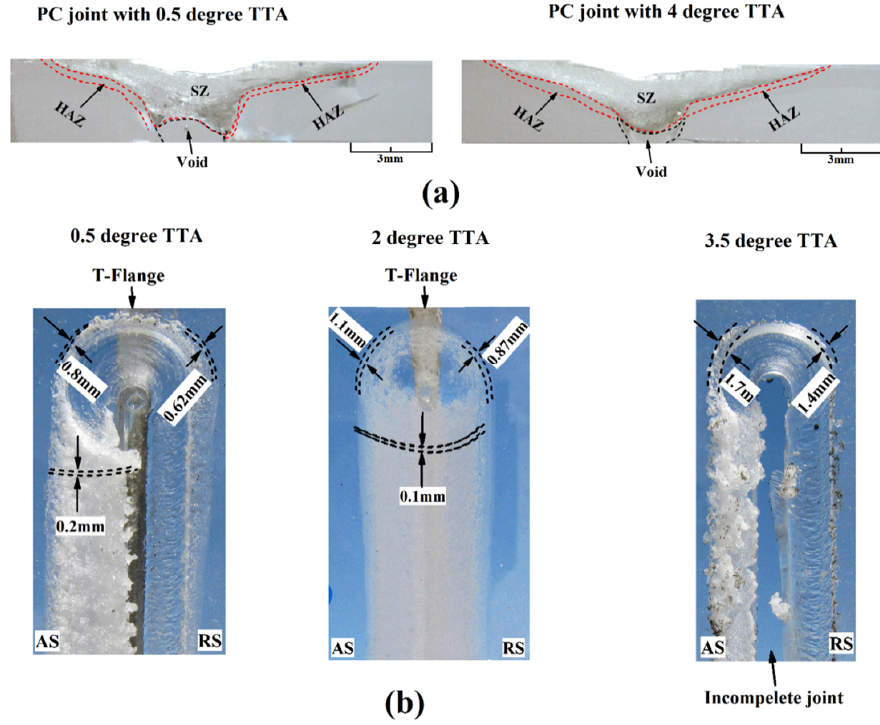
Figure 15. ( a ) E ff ects of tool tilt angle (TTA) on internal flow of PC joint after LFSW [51], ( b ) e ff ects of LFSW tool tilt angle on surface flow of PMMA T-joint [56].